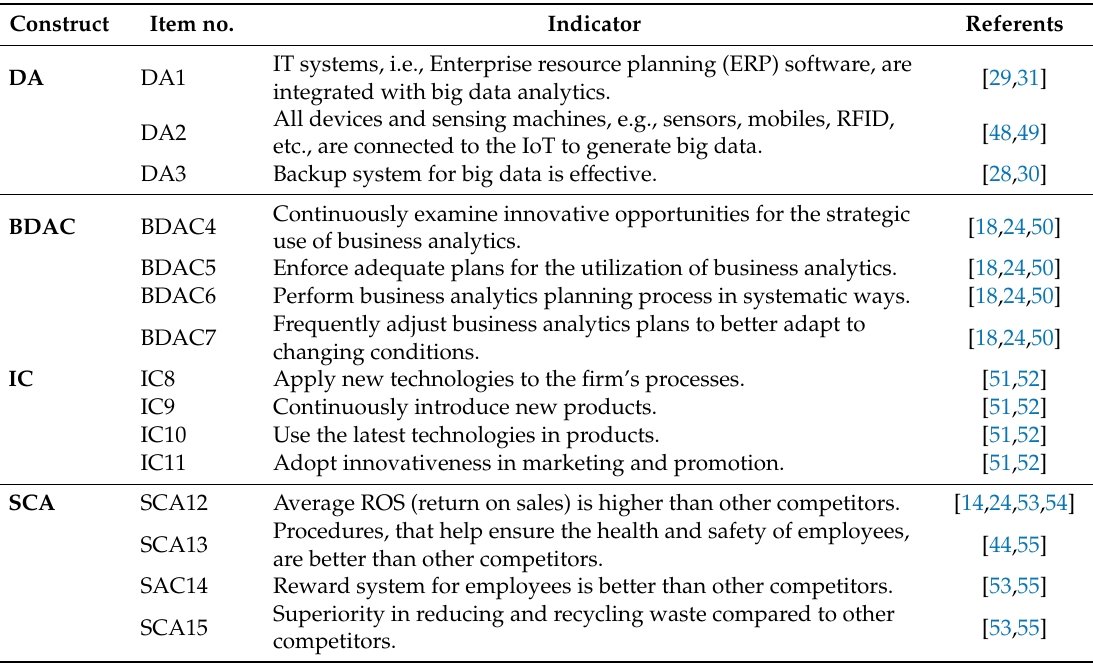
Figure 1. The proposed research model. Table 1. Model